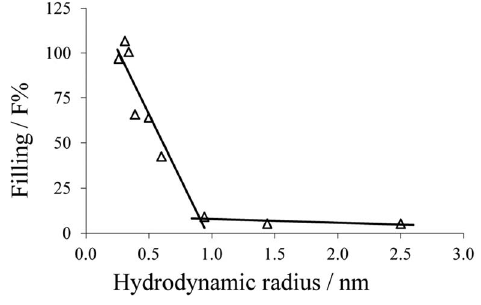
Figure 3. Dependence of the channel filling F % on the hydrodynamic radii of nonelectrolytes. F % for each nonelectro- lyte was calculated according to Eq. 3. Lines are best fits to the experimental points. The channel filling of maltose, PEG 400 and PEG 600 was not included in this diagram, because the calculated values of F and F % were unreasonably high and could not be used due to possible interactions of these compounds with the channel interior (for details see text). The horizontal lines connect the points derived from measurements in the presence of PEG 1,000, PEG 3,000 and PEG 6,000. The other line regression was used to describe the points for the nonelectrolytes with radii ranging from 0.26 nm to 0.6 nm (ethylengly- col, glycerol, arabinose, sorbitol, PEG200, PEG300). Hydrodynamic radii of the nonelectrolytes were taken from table 2.